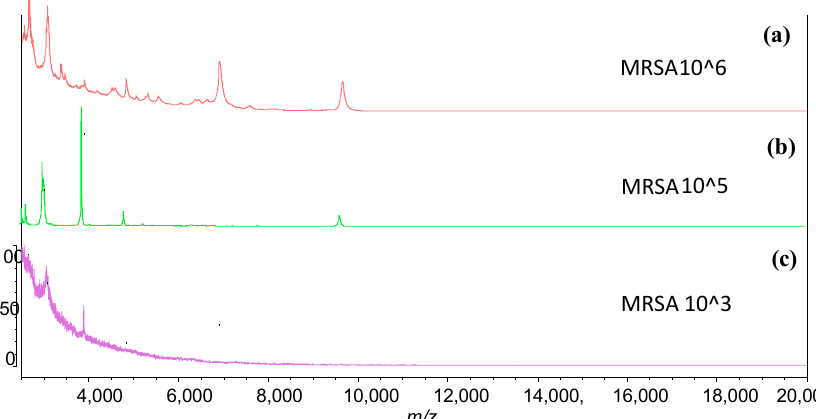
Figure 7. MALDI spectra of MRSA ( a ) obtained from a pure culture at a concentration of 10 6 CFU/mL, ( b ) captured with PAMNP-aptamer in the bacterial mixture containing MRSA and two other species ( S. aureus and E. coli ) at the same concentrations of 10 5 CFU/mL, and ( c ) captured with PAMNP-aptamer in the bacterial mixture containing the three species at the same concentrations of 10 3 CFU/mL.